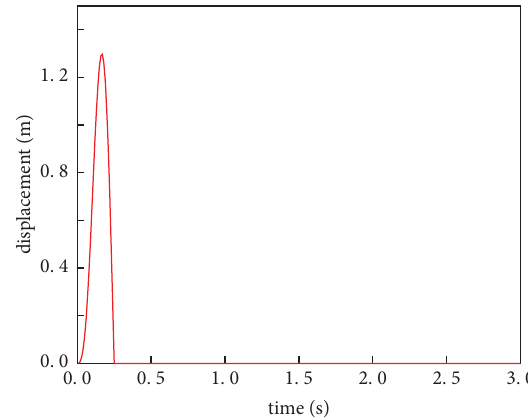
Figure 3: Incident wave displacement time-history curve.